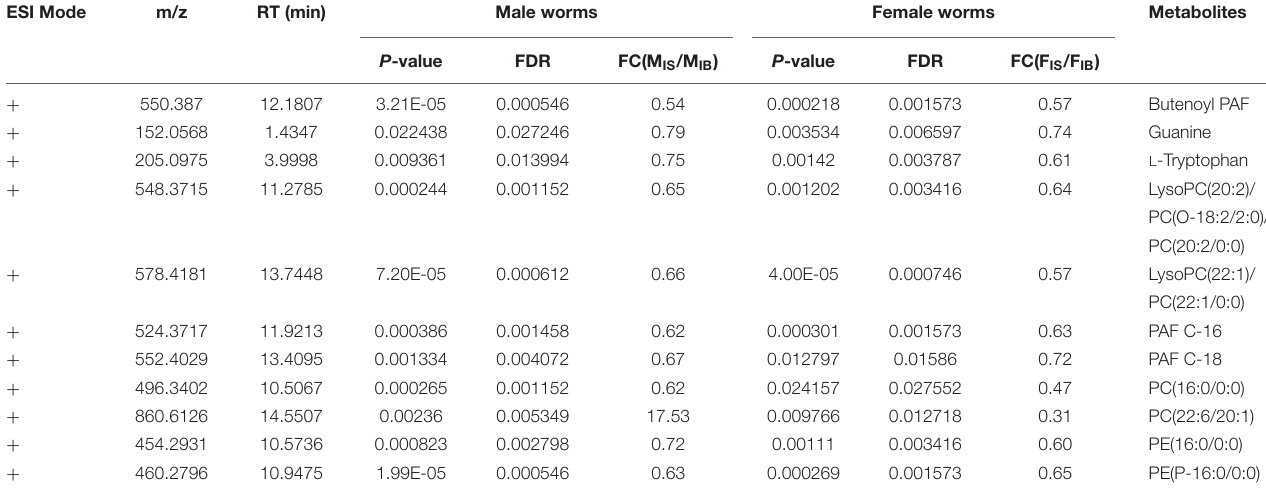
TABLE 1 | List of the common differential metabolites in male and female worms from SCID mice.